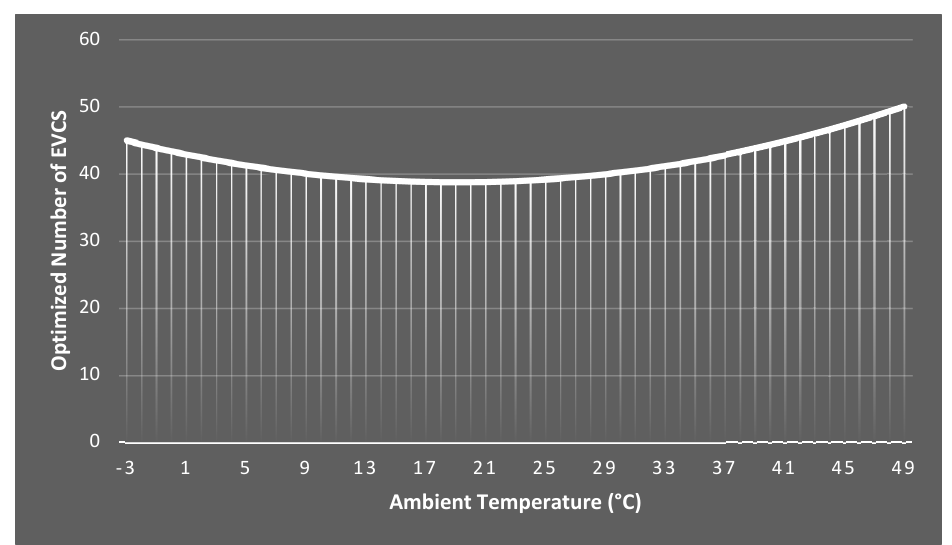
Figure 10. Number of EVCS with respect to Ambient Temperature.